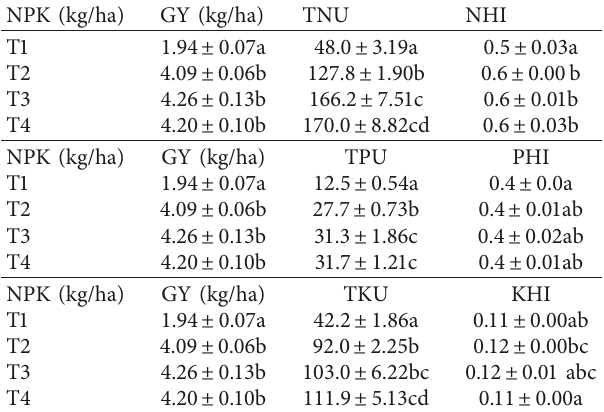
standard deviation. ± Table 4: Analysis of variance (ANOVA) for grain yield, total aboveground N, P, and K uptake, and N, P, and K harvest index (NHI, PHI, and KHI).